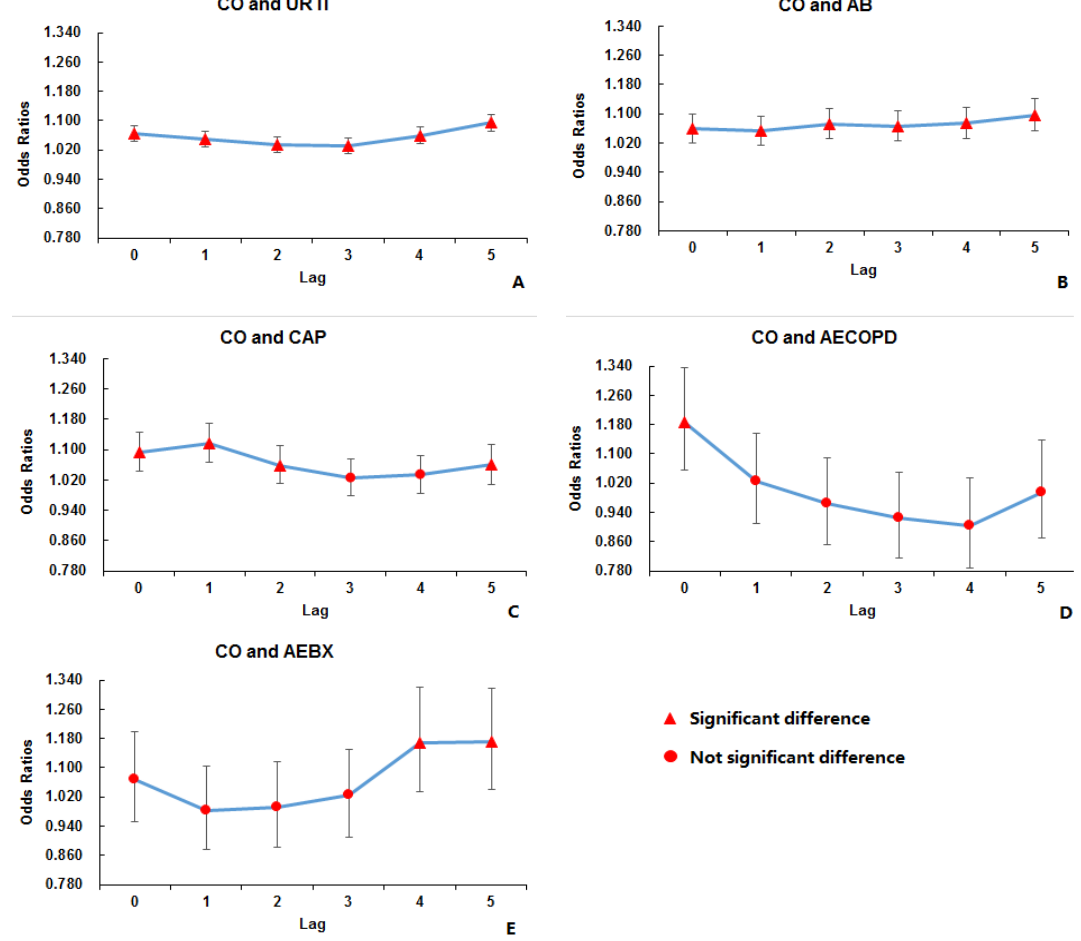
Figure 2. Association between CO and outpatient visits for different acute respiratory outcomes in panels A – E . ( A ) Association between CO and outpatient visits for URTI; ( B ) Association between CO and outpatient visits for AB; ( C ) Association between CO and outpatient visits for CAP; ( D ) Association between CO and outpatient visits for AECOPD; ( E ) Association between CO and outpatient visits for AEBX. Horizontal axis represents the days lagged from 0–5, and vertical axis represented the odds ratios. The highest odds ratios appeared in the association with AECOPD in lag 0 (odd ratio (OR) = 1.188, 95% confidence interval (CI) 1.056–1.335).